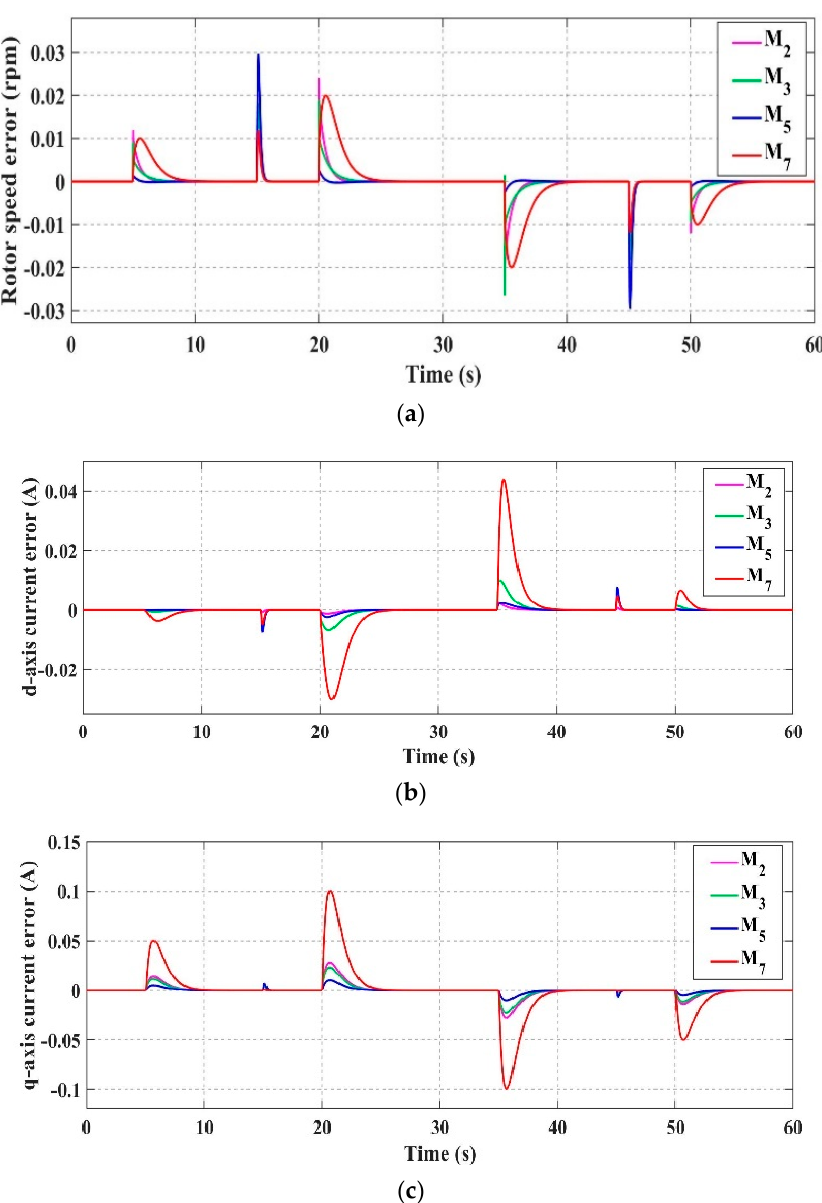
Figure 9. Errors measured in the vector control method. ( a ) Rotor speed error; ( b ) d -axis current error; ( c ) q -axis current error.